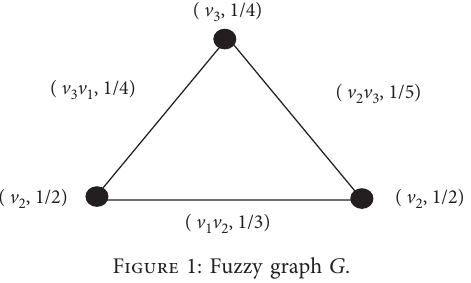
Figure 1: Fuzzy graph G .